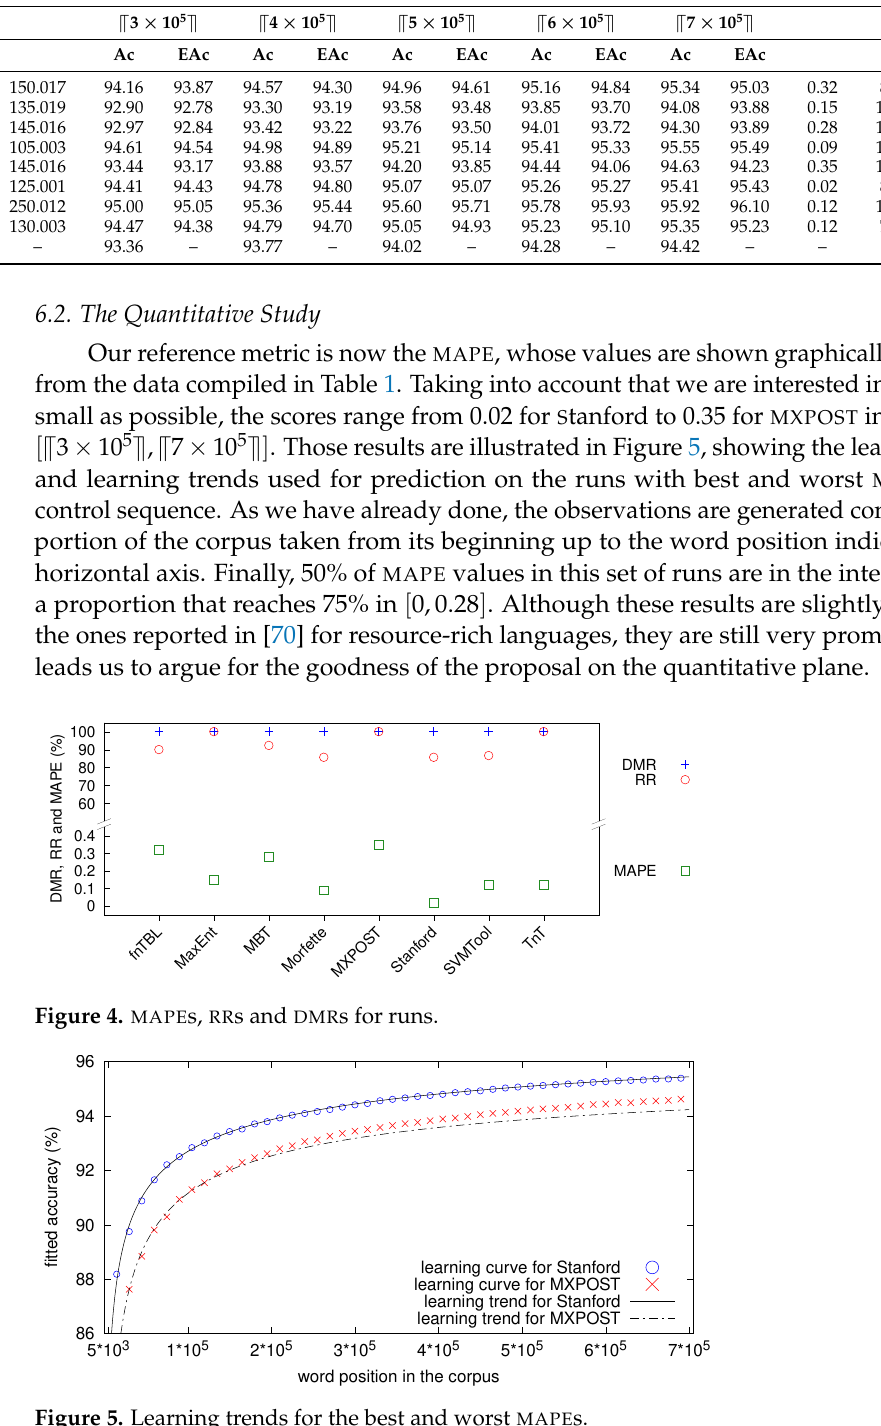
Figure 5. Learning trends for the best and worst MAPE